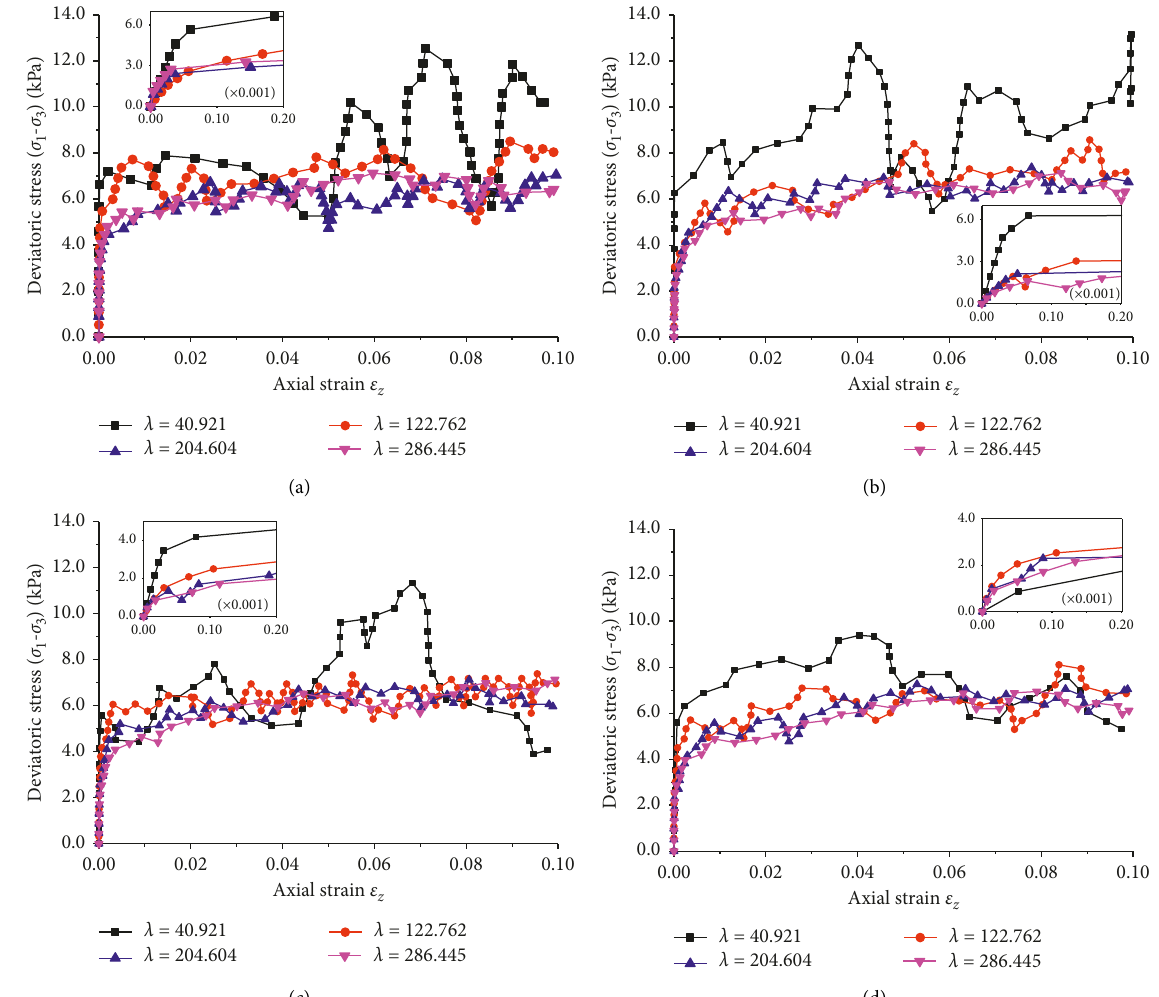
Figure 4: Influence of size effect on deviatoric stress - axial strain relationship of RVEs. (a) Size effect related to RVE height at 0g. (b) Size effect related to particle size at 0g. (c) Size effect related to RVE height at 5 g. (d) Size effect related to particle size at